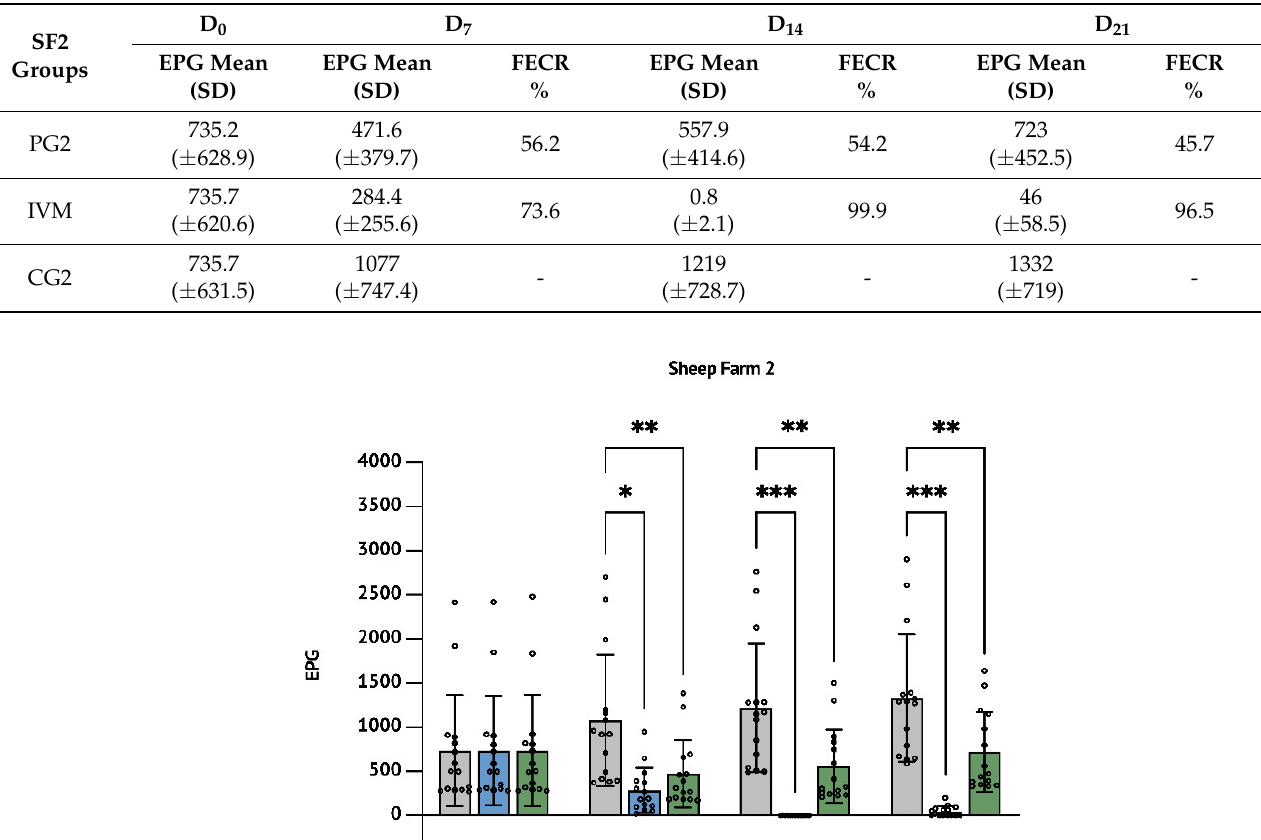
Table 2. Sheep farm 2 (SF2): results concerning the comparison between the anthelmintic efficacy of aqueous P. granatum macerate with Ivermectin. PG2: treated aqueous P. granatum macerate group 2 (50/mL/OS as a single dose); IVM: treated Ivermectin group (200 µ g/Kg B/W/SC as a single dose); CG2: untreated control group 2; gastrointestinal nematodes (GINs) eggs per gram (EPG) of faeces (mean) of the different groups and the faecal egg count reduction (FECR) (%) at different days (D) after treatment; SD (standard deviation).